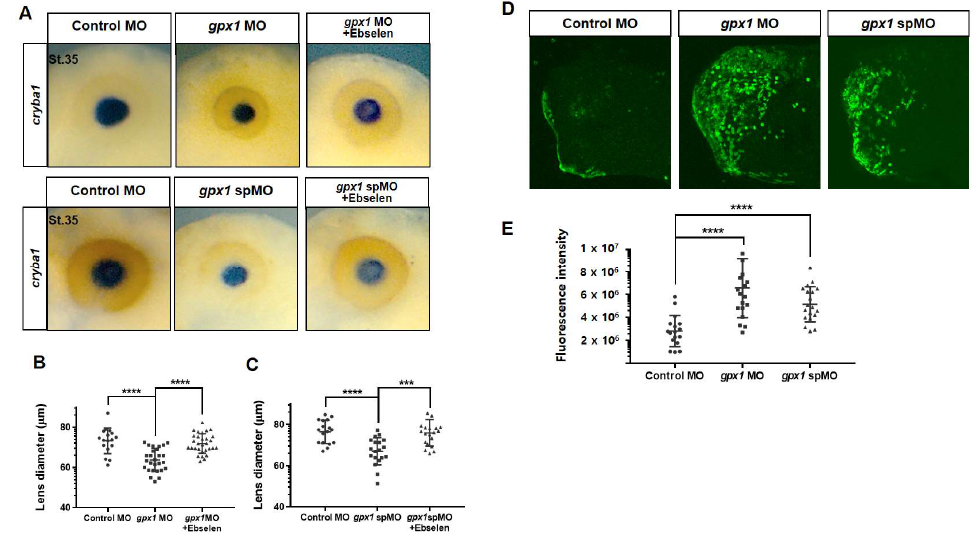
Figure 3. Loss of gpx1 results in a perturbed expression of the lens-specific marker and an accumu- lation of ROS in developing eyes during Xenopus embryonic development. Here, ( A ) 20-ng gpx1 MO and 5-ng gpx1 spMO were microinjected into the animal pole of two-cell stage embryos, and the embryos were processed for WISH analysis using the lens-specific marker cryba1 . The expression of cryba1 was remarkably reduced in both groups of gpx1 -morphant embryos. Moreover, the down- regulated expression of cryba1 was effectively rescued in gpx1 morphants after ebselen treatment. ( B ) A graphical representation of gpx1 MO-injected embryos revealed that gpx1 -morphant embryos exhibited a lens diameter of 70 μm compared with >80 μm in the control embryos, and it was effec- tively recovered to 80 μm in the gpx1 -depleted embryos after ebselen treatment. **** P ≤ 0.0001. ( C ) Statistical analysis of gpx1 spMO-injected embryos indicated that gpx1 -depleted embryos showed a lens diameter of approximately 75 μm as compared with >80 μm in the control embryos. The smaller size of the lens was effectively rescued to 80 μm after ebselen treatment in the gpx1 spMO-injected embryos. *** P ≤ 0.001, **** P ≤ 0.0001. ( D ) Both gpx1 MOs with HyPer mRNA (10 ng) were injected into the D.1.2. blastomeres of 16 cell stage Xenopus embryos and the gpx1- depleted embryos exhib- ited increased fluorescence intensity in the eye regions compared with the control embryos. ( E ) Hy- Per fluorescence intensity quantification clearly showed significant intense fluorescence in the gpx1 MO and gpx1 spMO injected embryos as compared with the control embryos. **** P ≤ 0.0001.